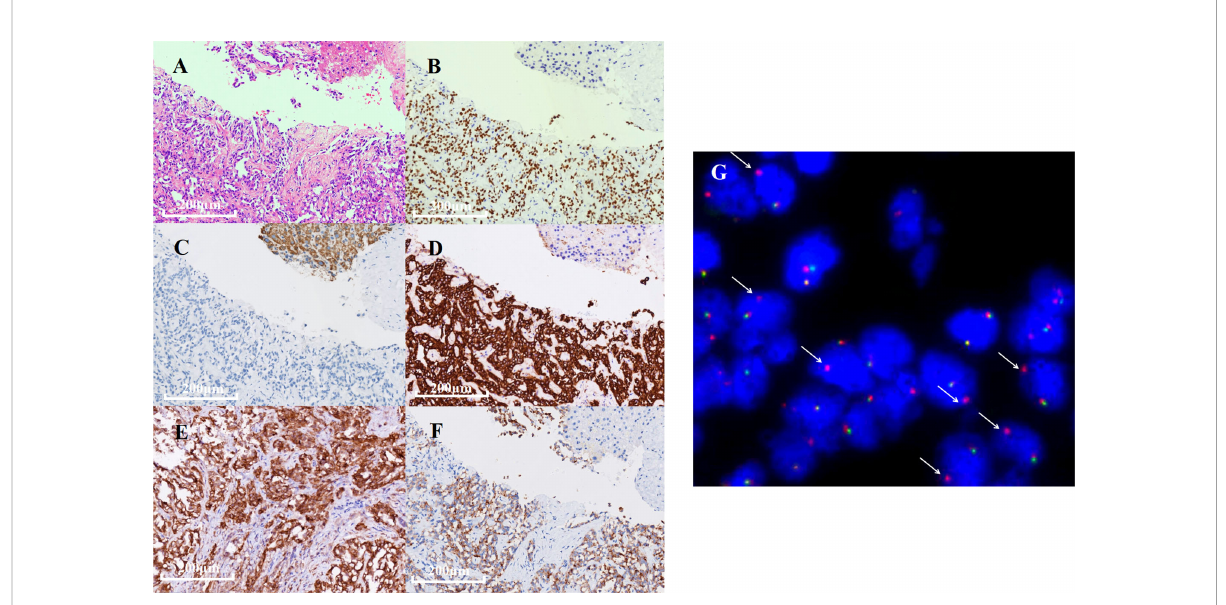
FIGURE 2 Immunohistochemistry (IHC) and fl uorescence in situ hybridization (FISH) results of the biopsy specimen. (A) Hematoxylin and eosin staining revealing an adenocarcinoma. (B – F) IHC results of TTF-1, Hepa, CK-7, PD-L1, and ALK expression detected by D5F3 IHC assay. (G) FISH showed ALK gene rearrangement positive signal (one red and one yellow, indicated by white